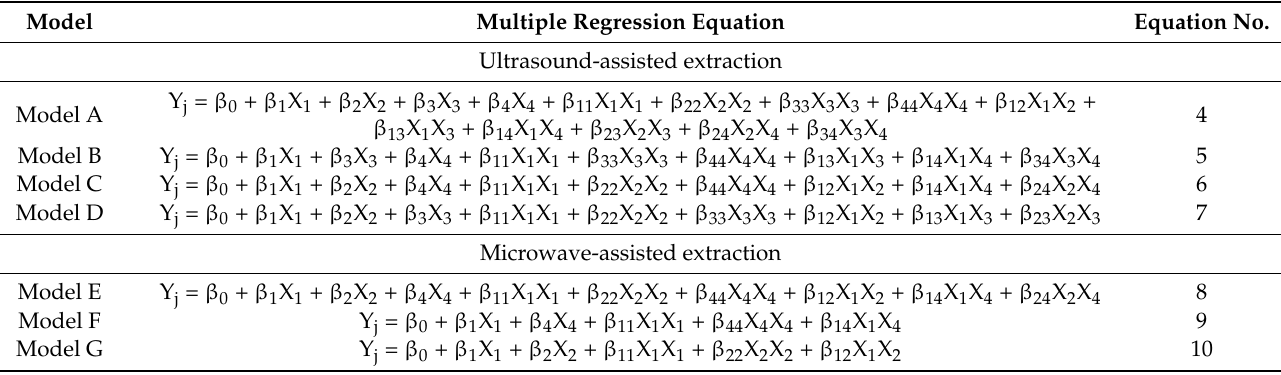
Table 11. Multiple regression equation for ultrasound-assisted extraction and microwave-assisted